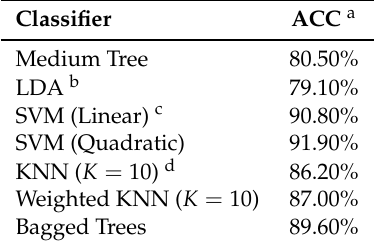
Table 3. Classification accuracy comparison of different classifiers using basic